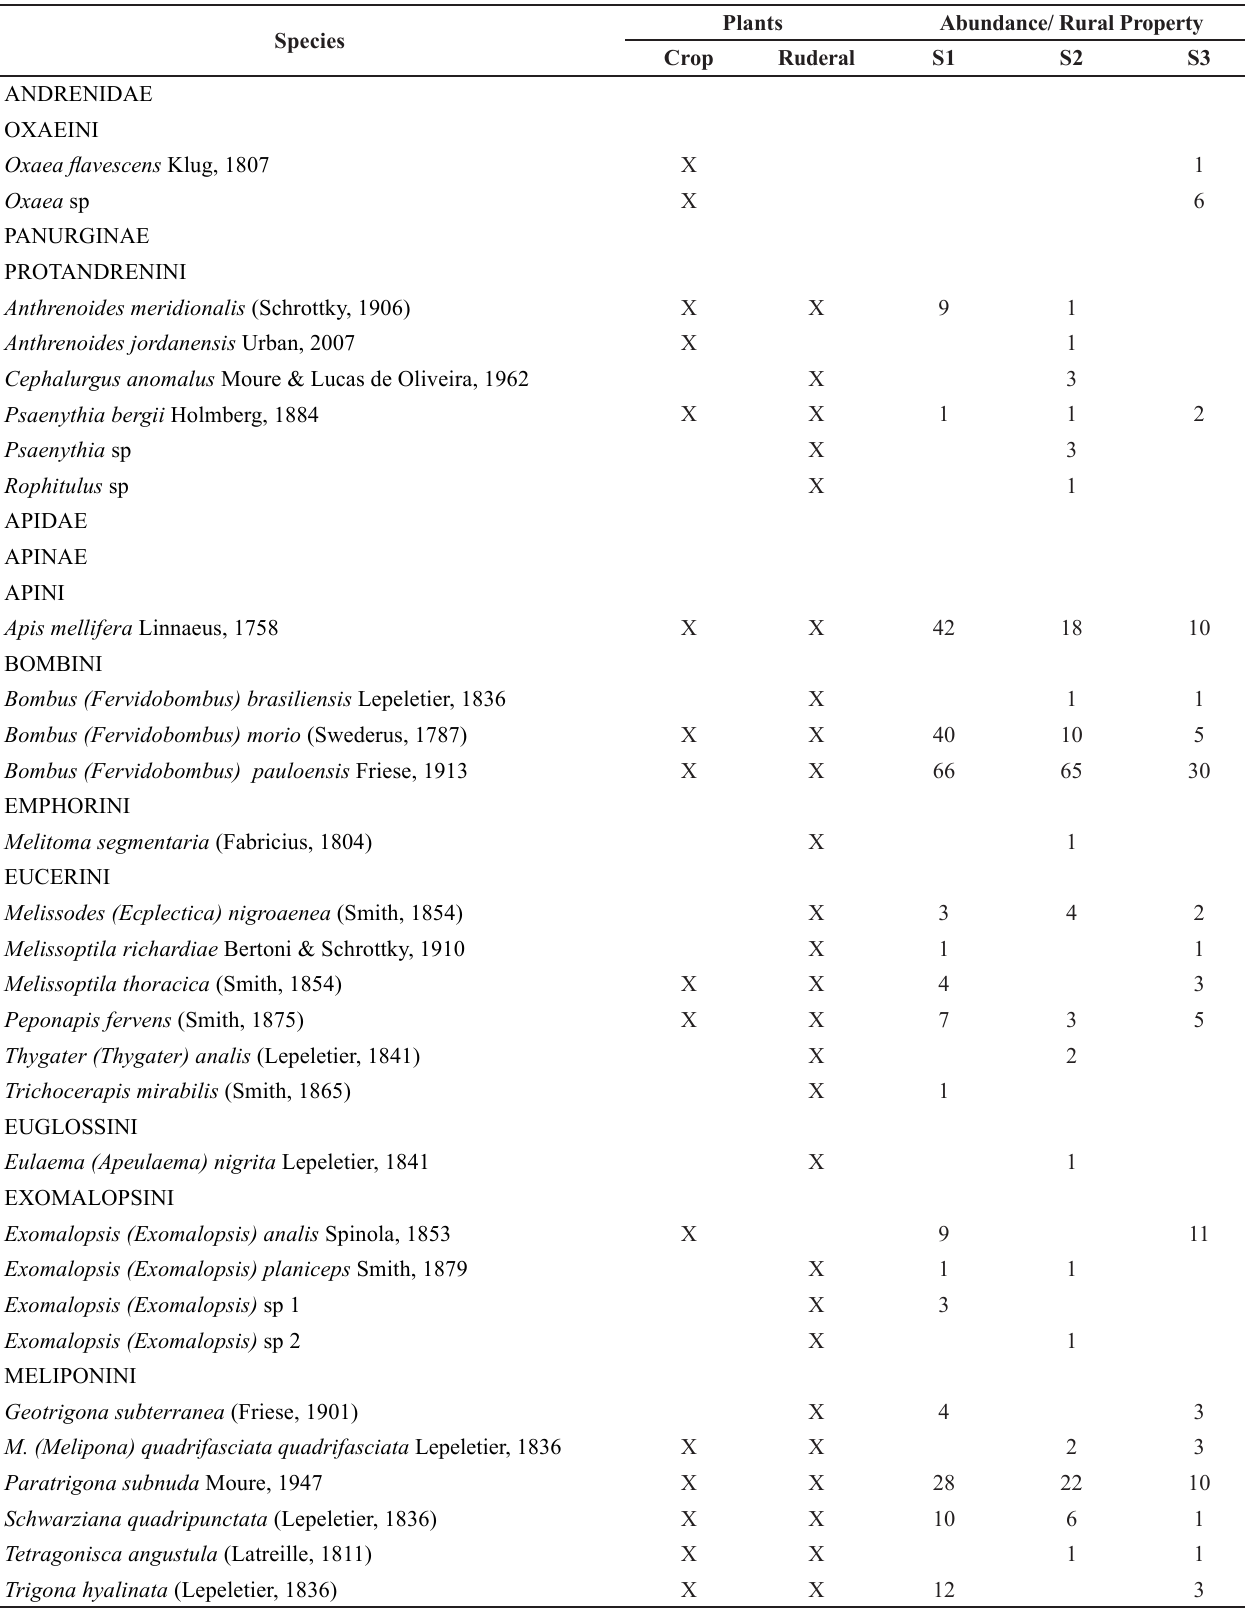
Table 2 . Bee species, abundance and type of plant visited at three smallholder rural properties in Guapiara, São Paulo state, Brazil, between May 2012 and March